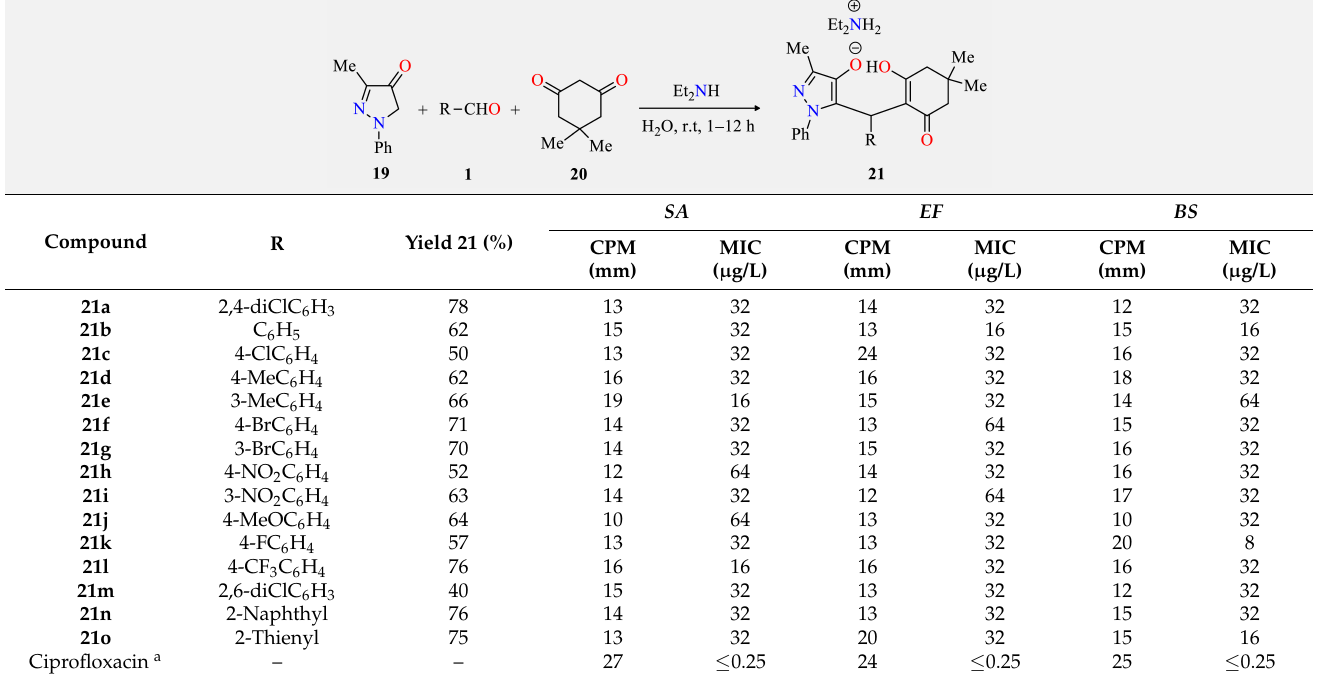
Table 4. Four-component synthesis and antibacterial evaluation of pyrazole-dimedone derivatives 21 .